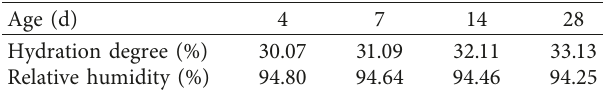
Figure 6: The relationship of hydration degree and relative hu- midity in sealed curing. Table 3: The relative humidity corresponding to different hy- dration degree in dry